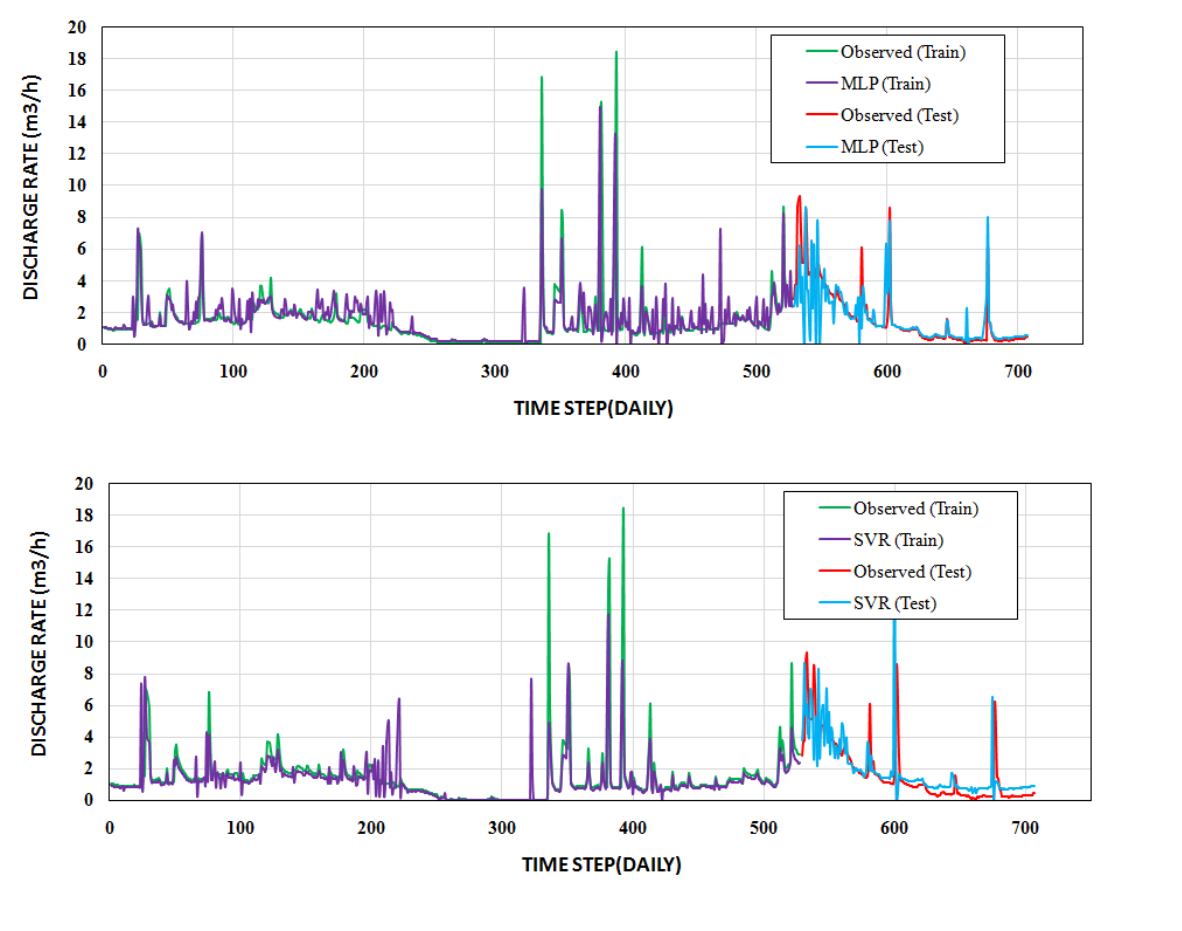
Figure 4: The simulated time series of the flow by models of MLP and SVR according to PERSIANN satellite data the absence of the appropriate estimation of precipitation by TRMM in Figure 5 shows the time series simulated using data of TRMM 3B42 those days. Also, at the beginning of the accuracy verification period, both satellite. The peak values during calibration period have been models have underestimated the flow rate to real underestimated than the observed values in most cases, which its reason is